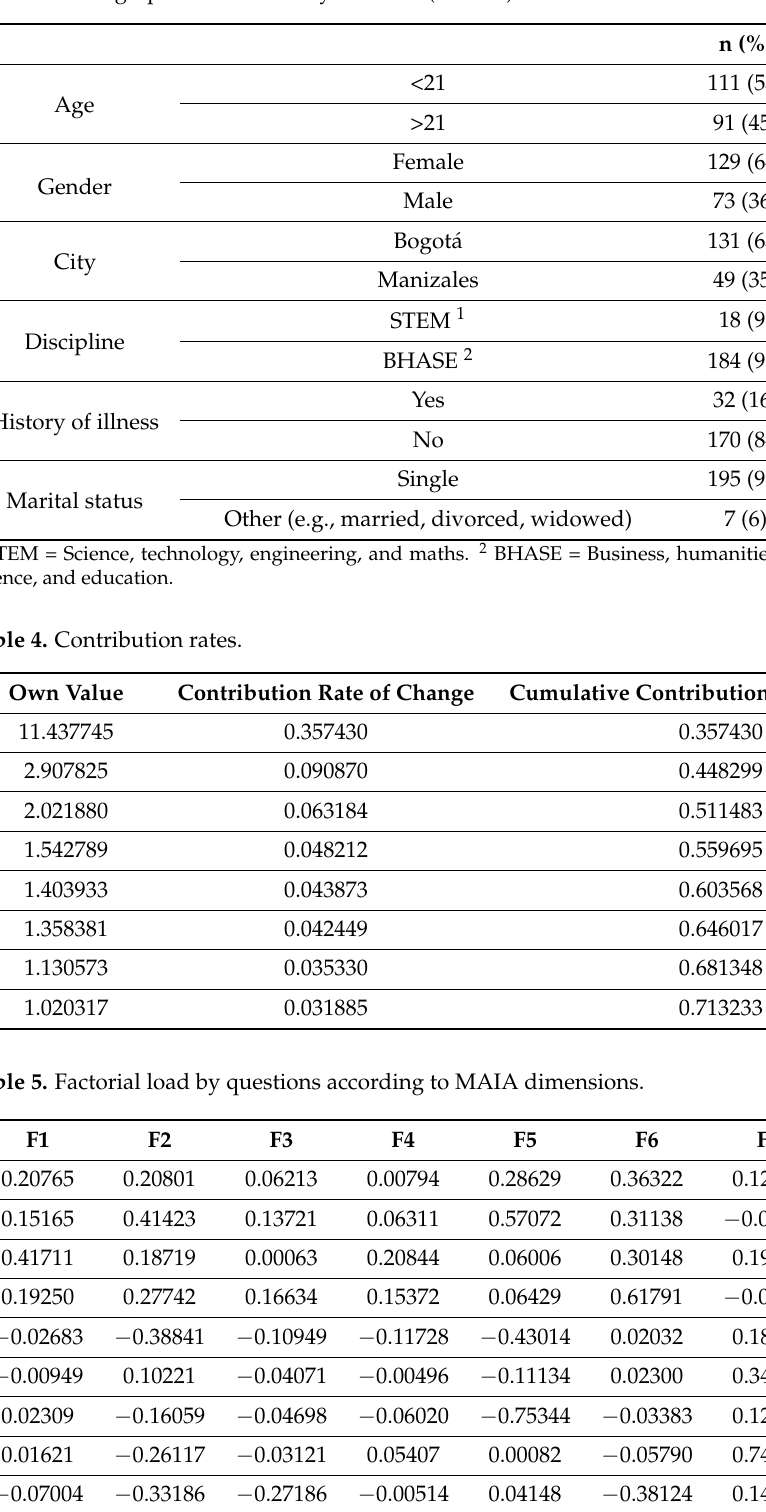
Table 3. Demographics of university students (n = 202).